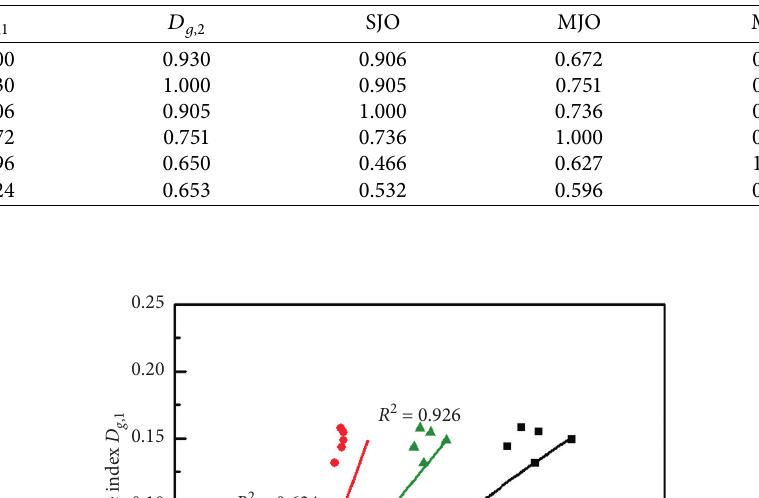
Table 2: Correlation between various indices.